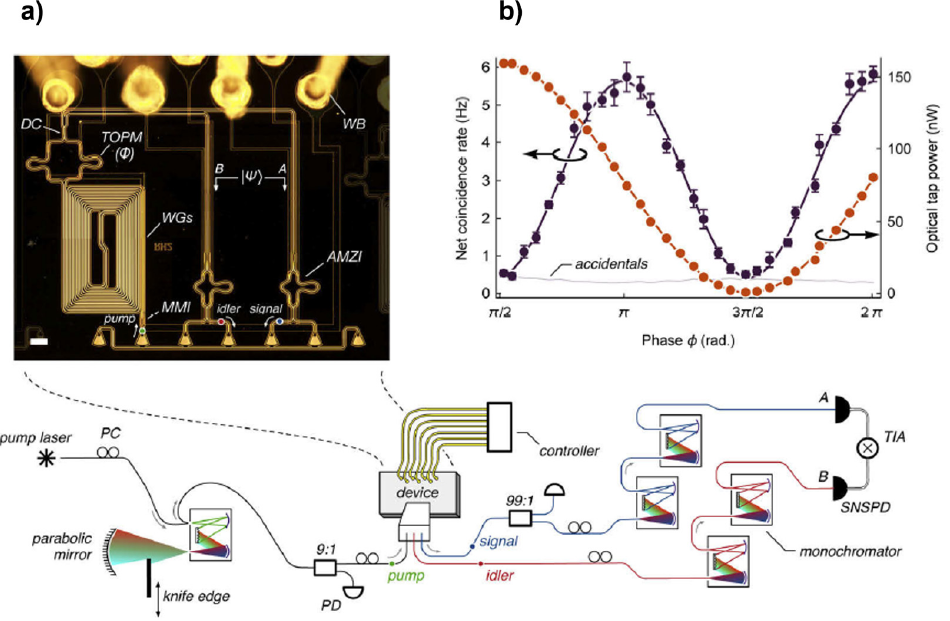
Figure 16. Experimental measurement of on chip quantum interference. ( a ) Schematic of the experimental set-up. The pump laser passes through a stage control (a polarization control PC and a double-pass monochromator filter) before being coupled into the waveguide circuit. A monitor photodiode (PD) is inserted at the input tap. The on-chip quantum state is controlled using a DC- voltage controller. A detection scheme consisting of superconducting nanowires and a time interval analyzer (TIA) is implemented to detect the signal and idler photons, after being filtered with a monochromator. ( b ) Experimental results showing quantum and classical interference fringes with varying on-chip phase φ . The fitted net visibility is V = 0.993 ± 0.017. Reproduced with